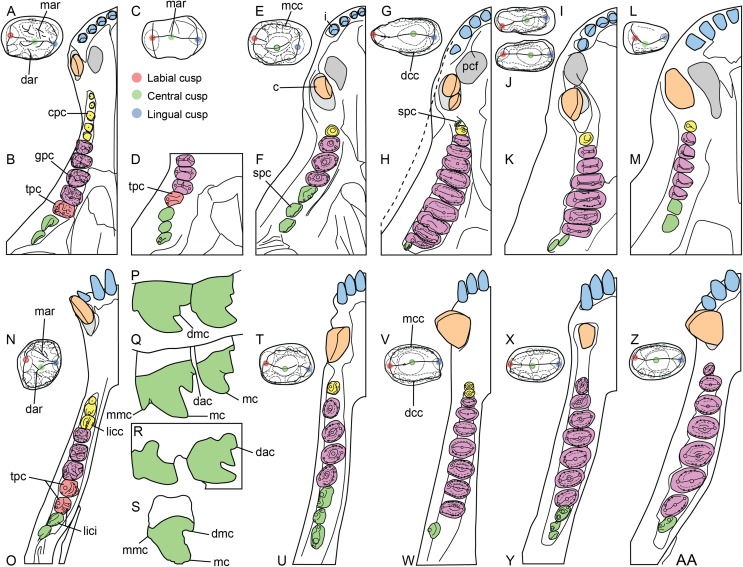
Dentition of non-traversodontid Gomphodontia.(A) Upper gomphodont postcanine (SAM-PK-571a); and (B) cranial dentition (mainly based on BSP 1934 VIII 14) of Diademodon tetragonus in apical and palatal views, respectively; (C) last right upper gomphodont postcanine; and (D) cranial dentition of Titanogomphodon crassus (GSN R322) in apical and palatal views, respectively; (E) upper gomphodont postcanine (reconstruction based on the fourth and third left upper gomphodont teeth of NMQR 3251 and 3255, respectively); and (F) cranial dentition (NMQR 3255) of Langbergia modisei in apical and palatal views, respectively; (G) last right upper gomphodont postcanine (UMCZ T905); and (H) cranial dentition (reconstruction based on BP/1/6102 and UMCZ T905 for the anterior and posterior portions of the cranium, respectively, and NHCC LB28 for the anterior postcanine dentition) of Cricodon metabolus in apical and palatal views, respectively (the dashed-line represents the lateral margin of the cranium of NHCC LB28); (I and J) antepenultimate right upper gomphodont postcanines (NHM PV R3307, Trirachodon “kannemeyeri” morphotype, and BSP 1934 VIII 21, Trirachodon berryi morphotype, for (I) and (J), respectively); and (K) cranial dentition (BP/1/4658) of Trirachodon berryi in apical and palatal views, respectively; (L) fourth right upper gomphodont postcanine; and (M) cranial dentition of Beishanodon youngi (PKUP V3007) in apical and palatal views, respectively; (N) lower gomphodont postcanine (left anterior tooth of SAM-PK-571b); and (O) mandibular dentition (reconstruction based on MBR 1004 for the mandible, incisor and canine morphology, SAM-PK-571b and AM 3753 for the anterior postcanine dentition, and SAM-PK-K177 for the posterior postcanine dentition) of Diademodon tetragonus in apical and dorsal views, respectively; (P–S) upper sectorial postcanines of (P) Diademodon tetragonus (MB R1004); (Q) Langbergia modisei (NMQR 3251); (R) Trirachodon berryi (SAM-PK-4801); and (S) Cricodon metabolus (UMCZ T905) in labial view; (T) lower gomphodont postcanine (third right tooth of NMQR 5251); and (U) mandibular dentition (NMQR 3251) of Langbergia modisei in apical and dorsal views, respectively; (V) lower gomphodont postcanine (last right tooth of UMCZ T905); and (W) mandibular dentition (based on SAM-PK-5881a and UMCZ T905 for the anterior and posterior dentitions, respectively) of Cricodon metabolus in apical and dorsal views, respectively; (X) lower gomphodont postcanine (antepenultimate right gomphodont tooth of SAM-PK-K4801); and (Y) mandibular dentition (BP/1/4658) of Trirachodon berryi in apical and dorsal views, respectively; (Z) lower gomphodont postcanine (sixth and antepenultimate right gomphodont tooth of SAM-PK-K171); and (AA) mandibular dentition (SAM-PK-K171) of Trirachodon berryi (T. “kannemeyeri” morphotype) in apical and dorsal views, respectively. Abbreviations: c, canine (in orange); cpc, conical postcanine (in yellow); dac, distal accessory cusp; dar, distal accessory ridge; dcc, distal cingular cuspule; gpc, gomphodont postcanine (in violet); i, incisor (in blue); licc, lingual cingular cuspule; lici, lingual cingulum; mar, mesial accessory ridge; mc, main cusp; mcc, mesial cingular cuspule; mmc, mesial main cusp; pcf, postcanine fossa; spc, sectorial postcanine (in green); tpc, transitional postcanine (in red).